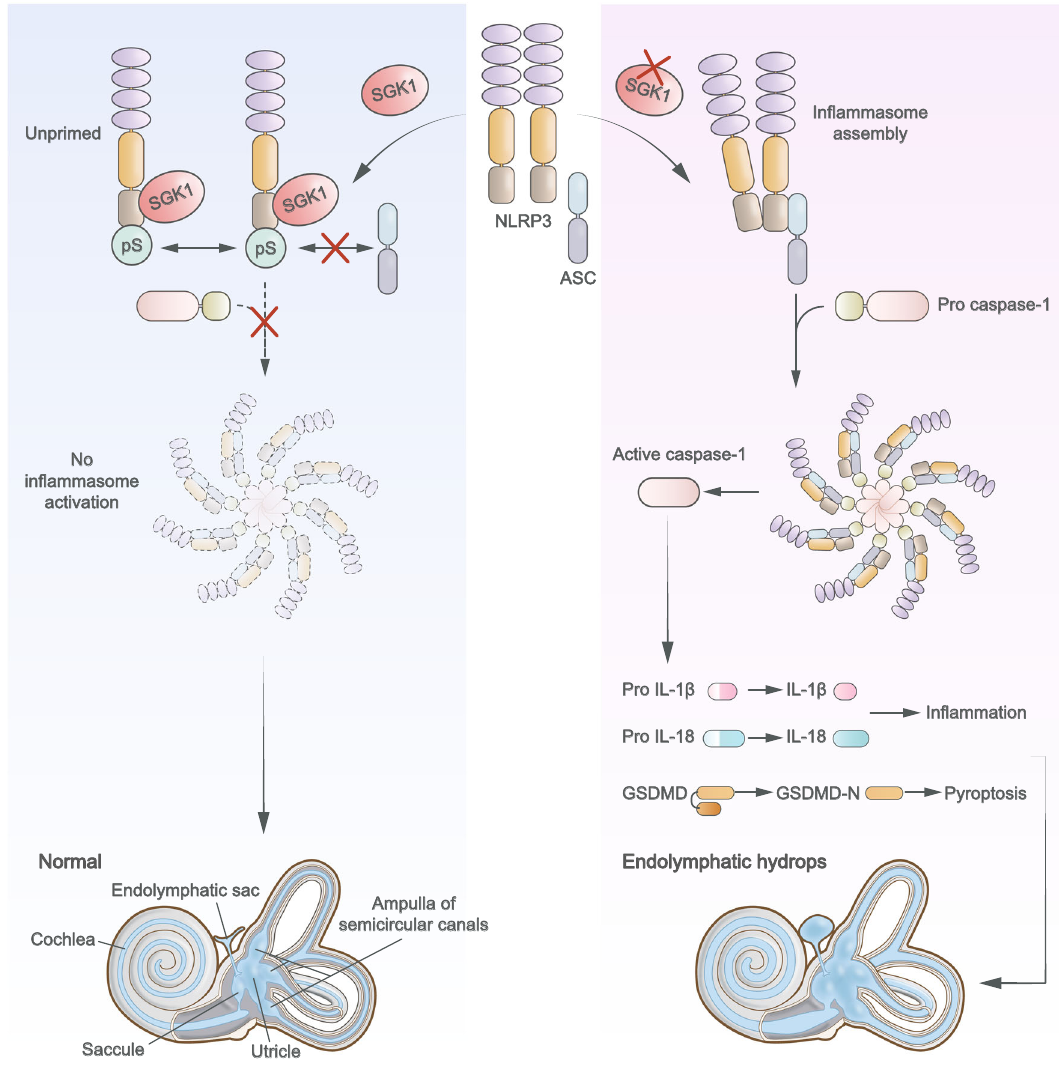
Fig. 8 | Schematic model for the mechanism by which SGK1 inhibits NLRP3 in fl ammasome activation to control inner ear in fl ammation. Under normal conditions, SGK1binds to the PYDdomain of NLRP3 and phosphorylates NLRP3 at S5,therebypreventingtheassemblyofthematurein fl ammasome.SGK1de fi